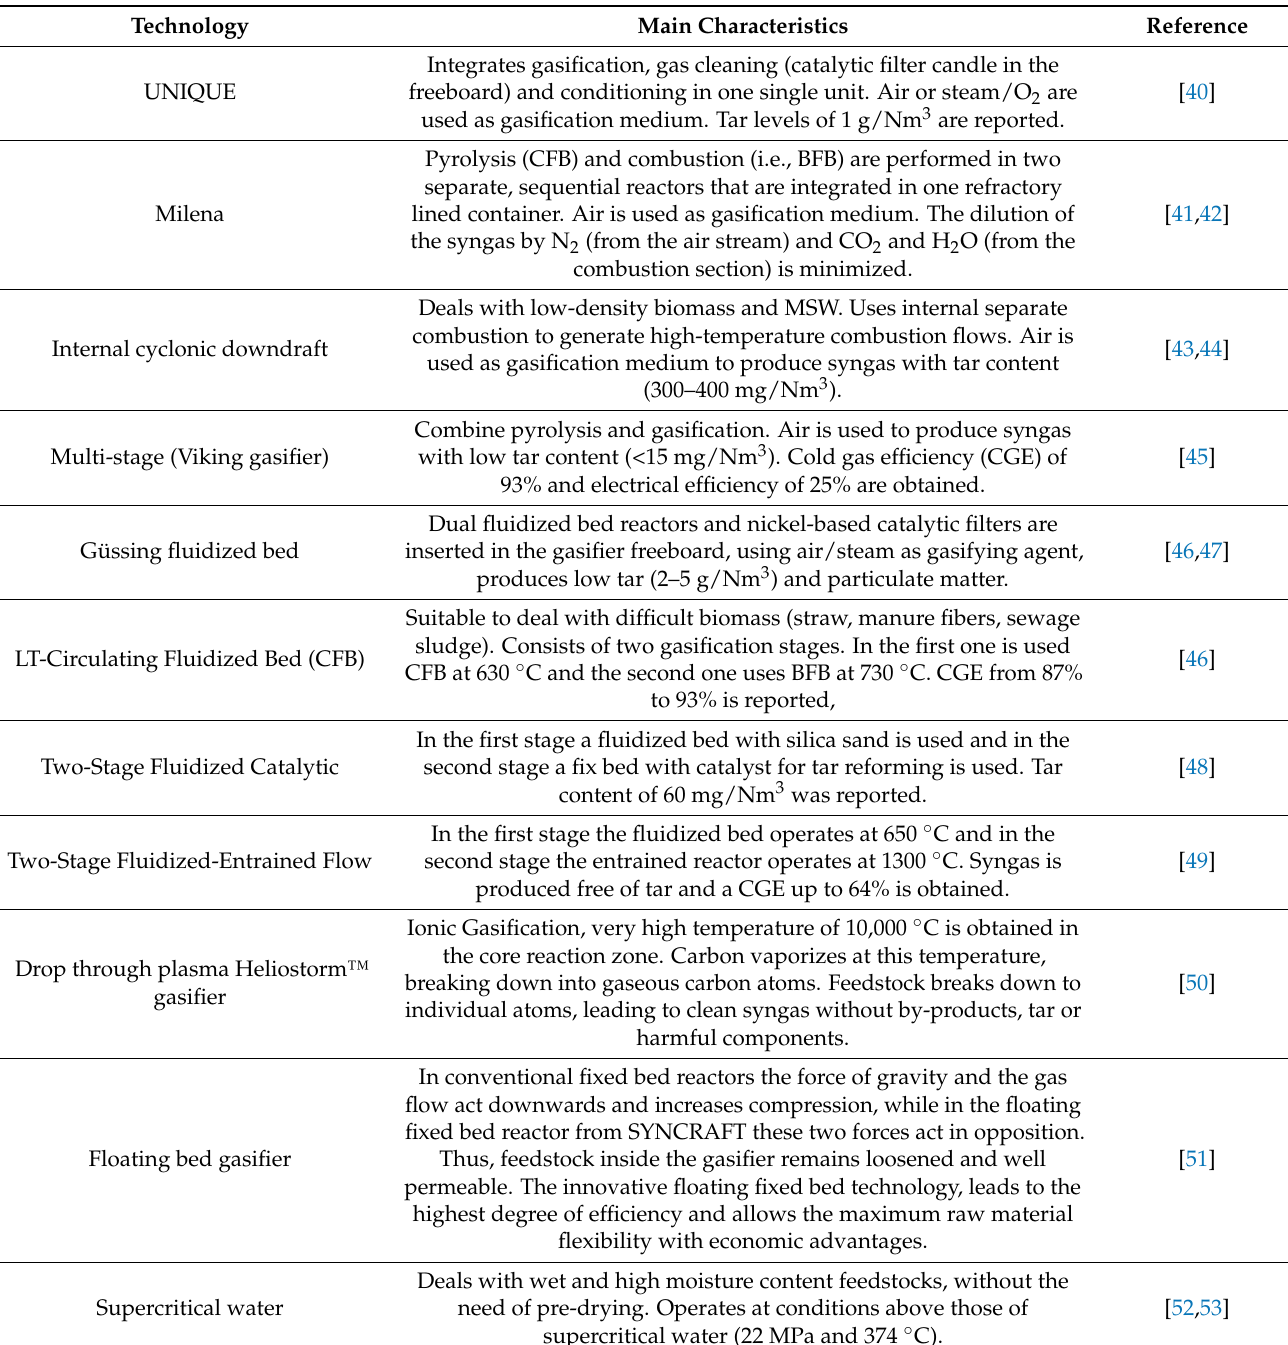
Table 3. The main characteristics of some advanced commercial gasifiers